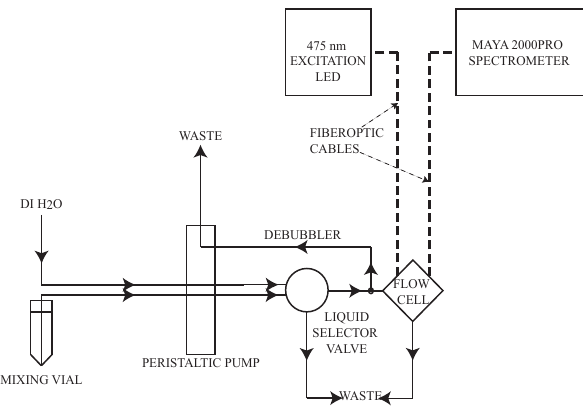
Fig. 1. Schematic for offline ROS analysis of standards and reagents combined in a mixing vial. DCFH+ROS (H 2 O 2 for calibrations) is pumped via the peristaltic pump through the flow cell, in which the concentration of DCF is measured at 530nm by the